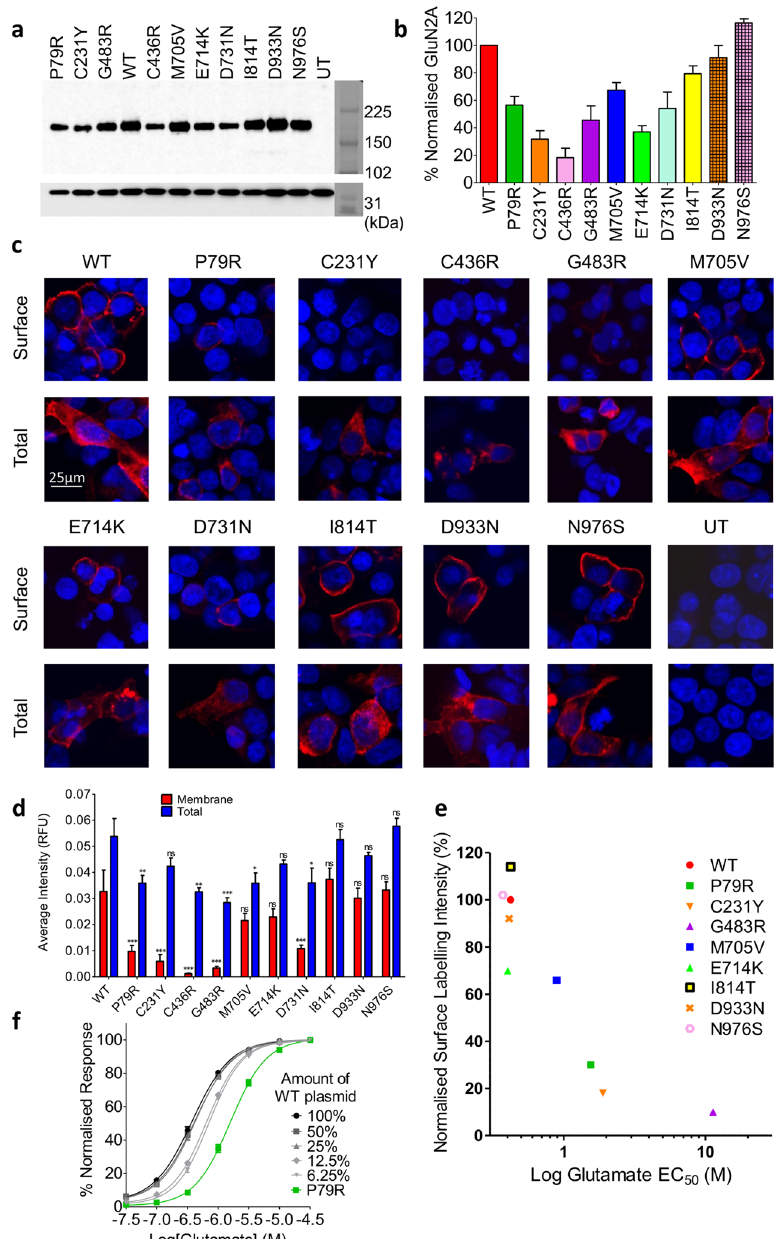
Figure 5. GRIN2A mutations reduce total protein levels and membrane trafficking of GluN2A. ( a ) Representative Western blot of HEK lysates probed with anti-GluN2A antibody (top), and anti-GAPDH (bottom) as a loading control. Bands around 180 kDa indicate GluN2A. WT, wild type, UT – untransfected. Right is Amersham Full-Range rainbow molecular weight marker with the blot imaged in visible light. ( b ) Plot of amount of GluN2A protein, normalised to WT, from Western blotting of total cell lysates of transiently co- transfected HEK cells 48-hours post transfection. Average of 3 blots from 3 independent transfections. Error bars indicated SEM. ( c ) Fixed and immunolabelled co-transfected HEK cells with anti-HA antibody (red) to detect surface GluN2A expression, and fixed, permeabilised and immunolabelled with the same antibody to detect total GluN2A protein levels. Scale bar 25 µ m. Nuclei stained with Hoechst (blue). ( d ) Quantitation of surface and total GluN2A protein levels, averaged over the total number of cells analyzed for each condition (n is between 903 to 2255 cells), reveals greatly reduced surface expression of GluN2A as measured by fluorescence intensity. Dunnett’s corrected one-way ANOVA for membrane or total intensity as compared to WT * p < 0.05, ** p < 0.01, *** p < 0.001, ns = non-significant. Average ± SEM. ( e ) Relative surface levels of NMDARs correlated with the log of glutamate EC 50 (Pearson’s coefficient of determination r 2 = 0.77, two-tailed p = 0.002). ( f ) Normalised CRC from single-cell calcium-flux imaging. Response to increasing concentrations of glutamate from HEK cells co-transfected with decreasing quantities of WT GRIN2A per well (100% = 320 ng) with standard 320 ng GRIN1 per well. Response is compared to mutant P79R. Error bars ±